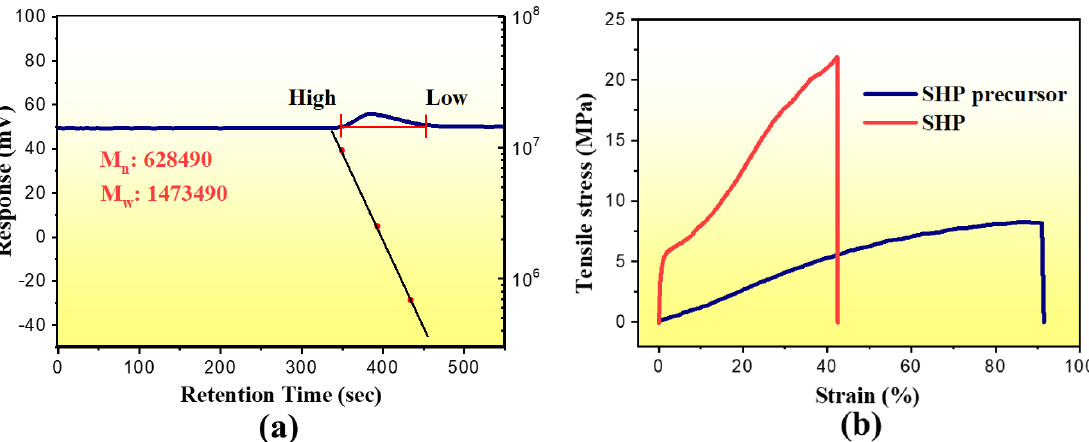
Figure 2. ( a ) GPC curve for self-healing polymer precursor in DMF solution. ( b ) Typical stress-strain (stress-stretch ratio) curves of SHP precursor and SHP.